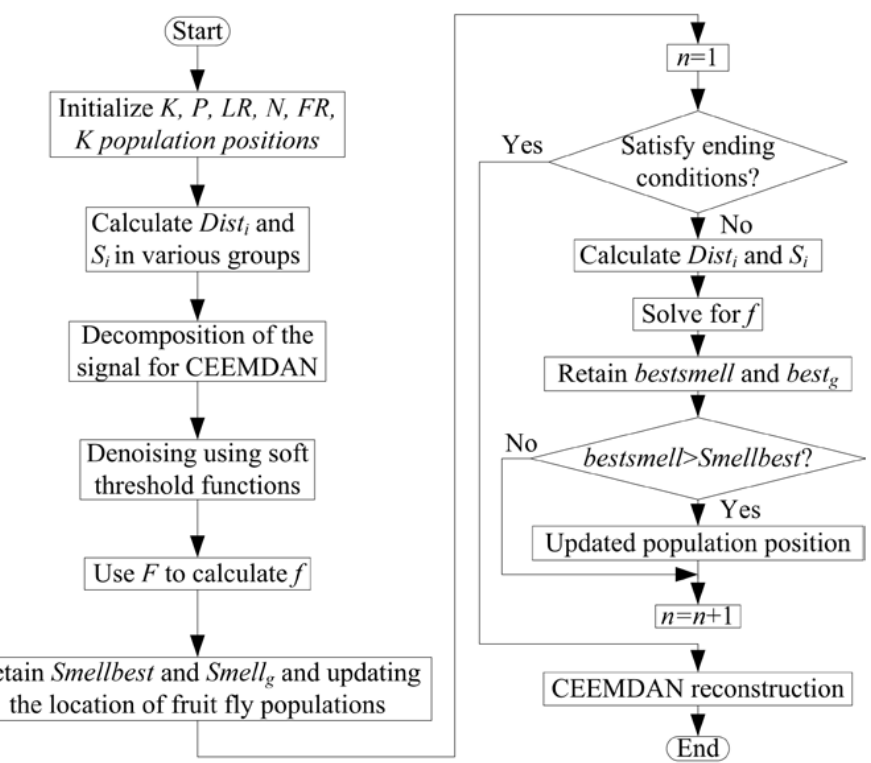
Figure 4. Based on the improved CEEMDAN coal–rock cutting sound signal denoising process.